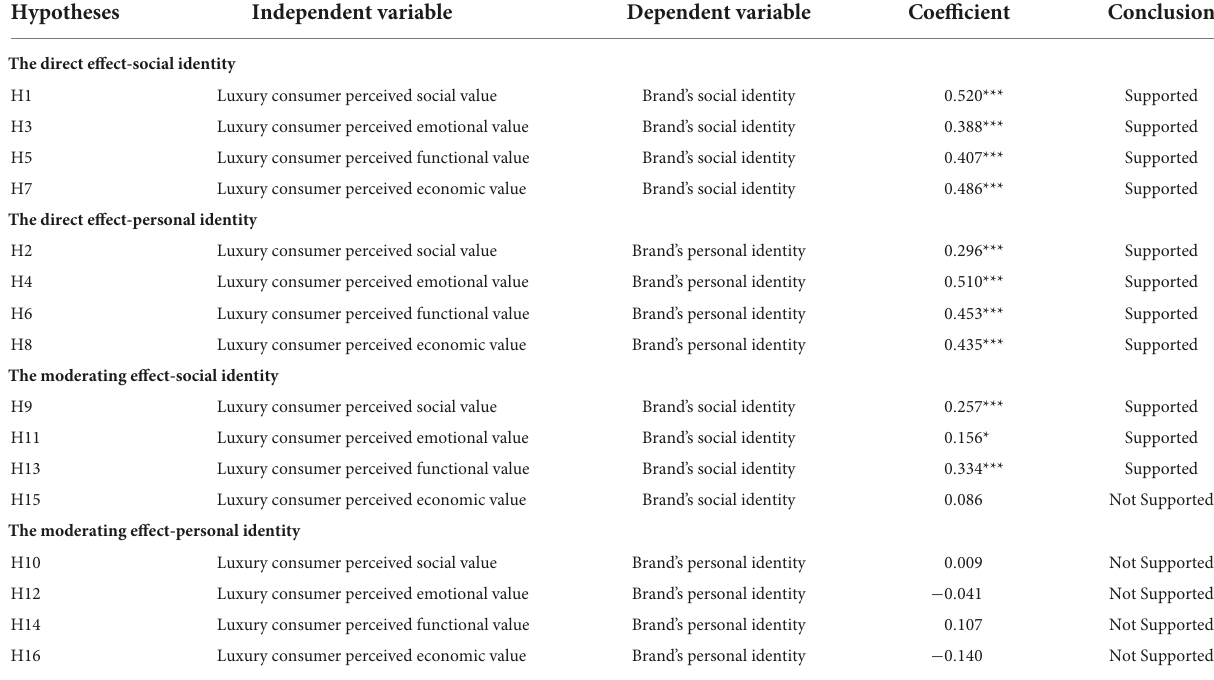
TABLE 6 Hypotheses testing